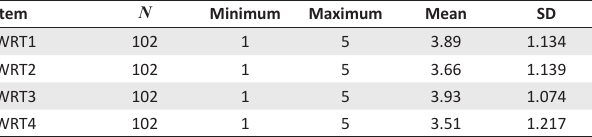
TABLE 11: Descriptive statistical analysis (Section B – work-related travel).